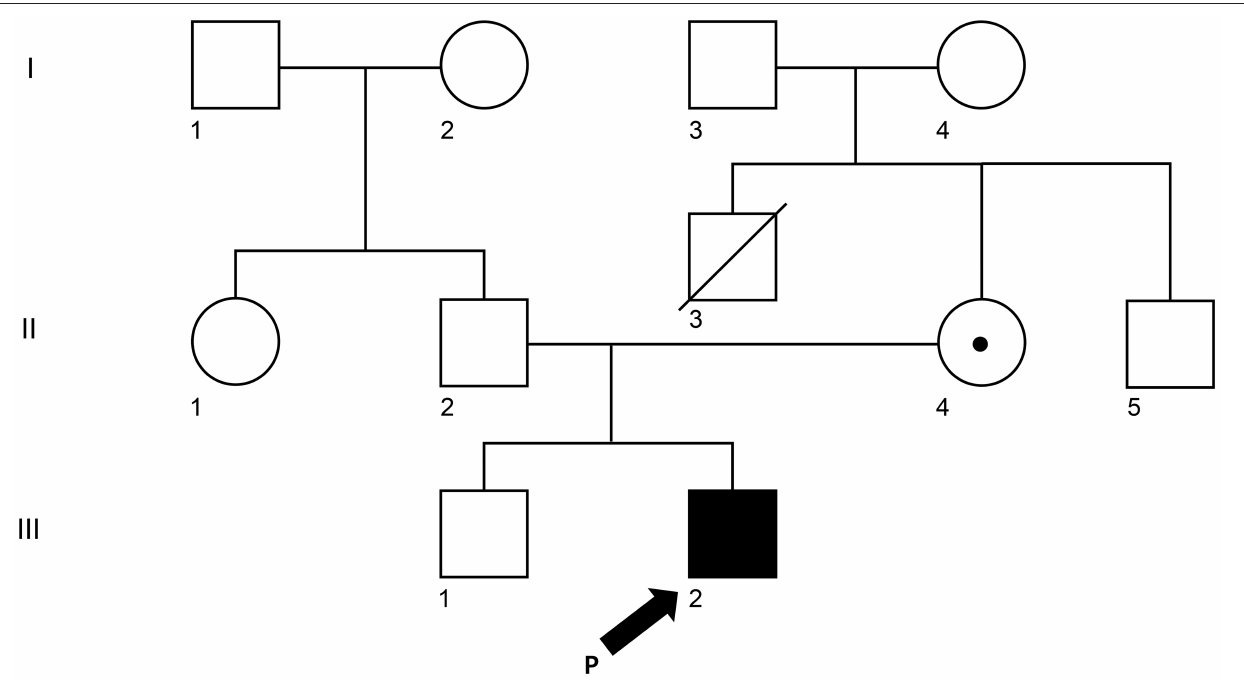
FIGURE 1 | Pedigree of the XLP1 case child. The arrow (III-2) is the proband. II-3 (his mother) and III-1 (his brother) were tested for the same variant. The white square represents a male individual who was unaffected, the white circle was for an unaffected female individual, and the dot represents the mother who is a carrier.